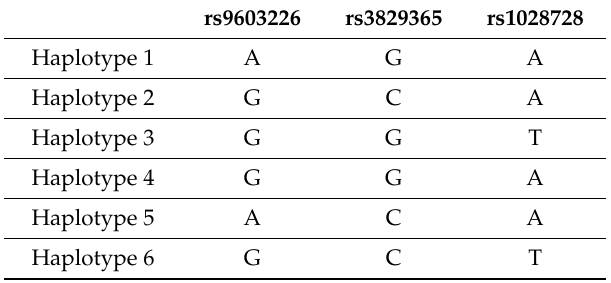
Table 1. POSTN gene haplotypes based on the allelic variants of the three polymorphisms